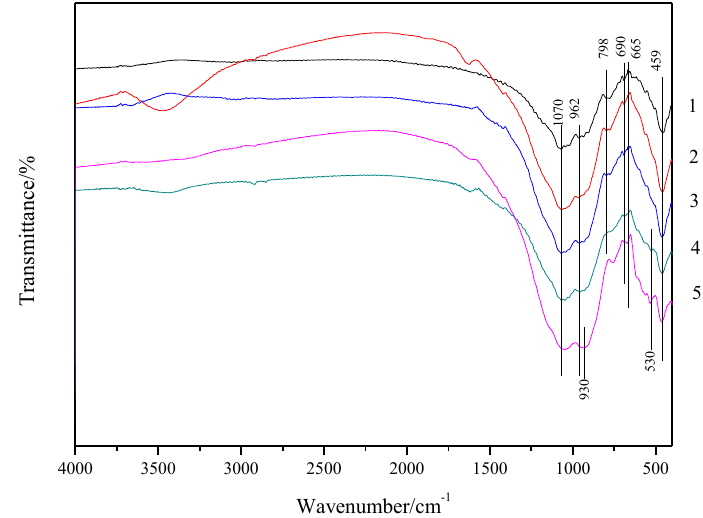
Figure 4. Fourier transform infrared (FTIR) spectra of samples 1–5 at optimum sintering temperature.